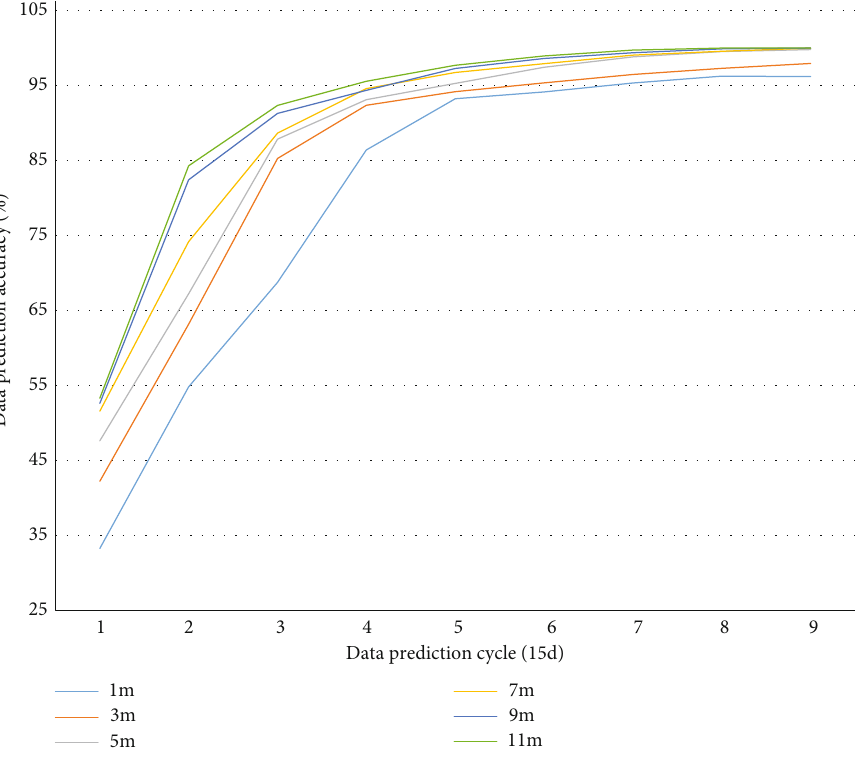
Figure 5: Data prediction accuracy was pushed 15 days ago under comprehensive conditions. Table 4: The forecast accuracy comparison table of stock price and stock